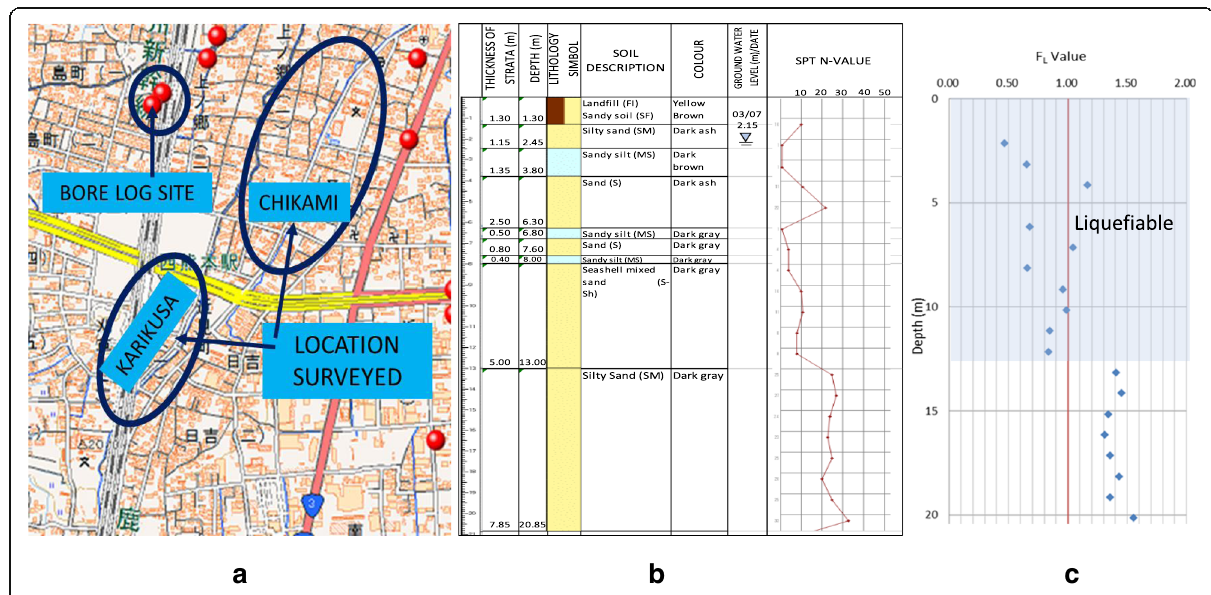
Fig. 13 a Bore log site in Chikami and Karikusa; b Borehole data obtained; c FL values calculation result for Chikami and Karikusa area